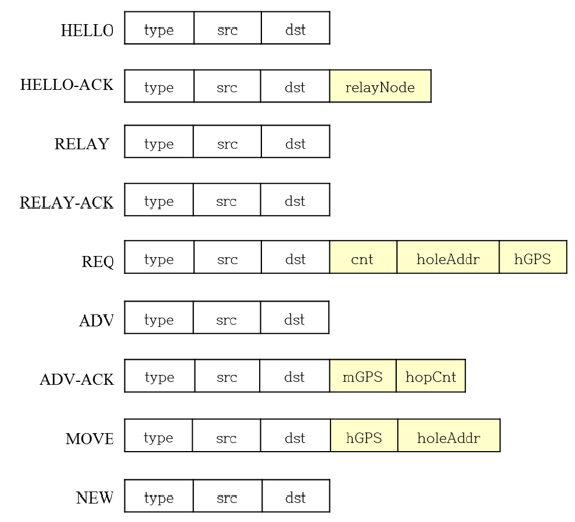
Figure 3. The message types for the proposed protocol.